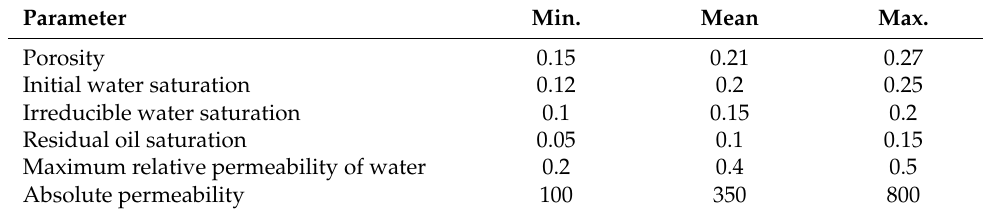
Figure 10. Sensitivity analysis of uncertain reservoir parameters. Table 2. Uncertain input variables for uncertainty assessment.